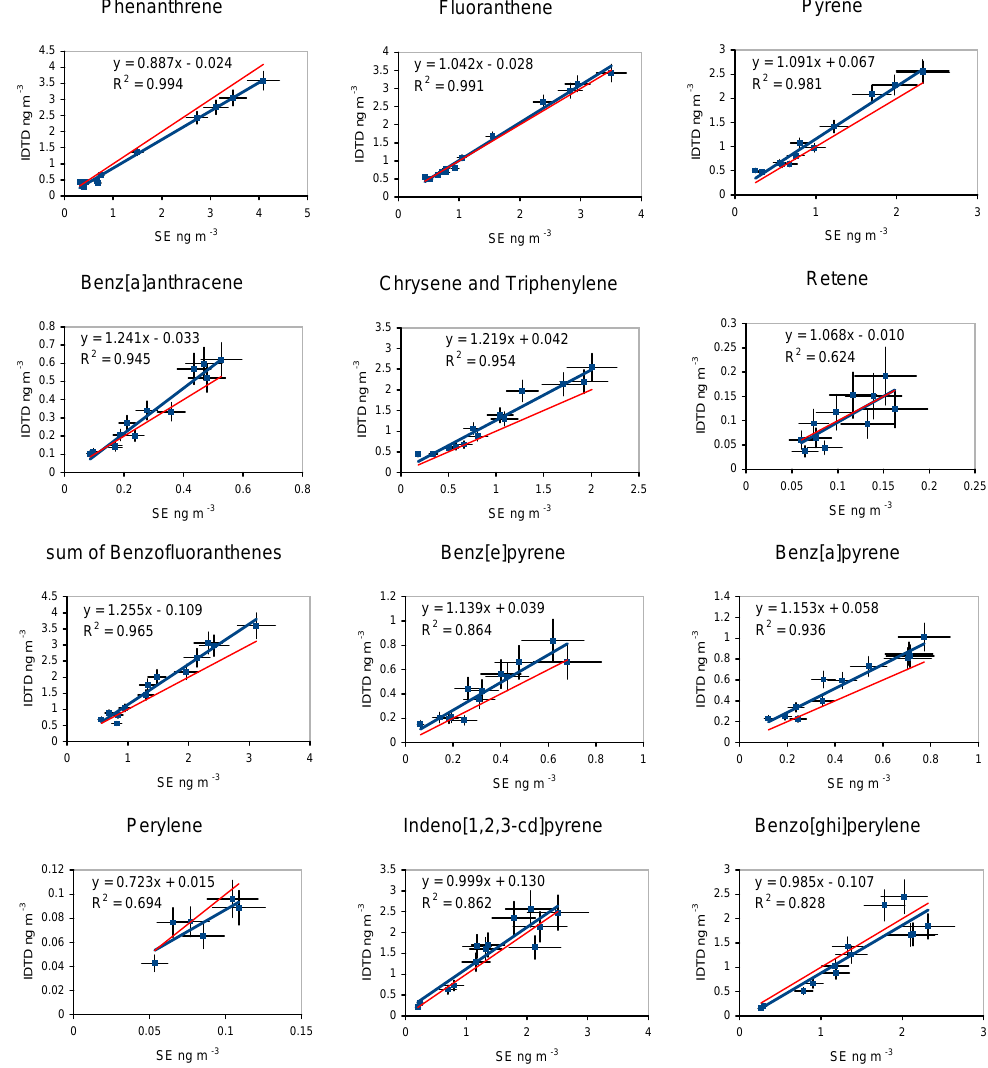
Fig. 5a. Correlation of IDTD and SE for analysis of PAH in ambient aerosol samples (blue: linear regression, red: line through origin, slope